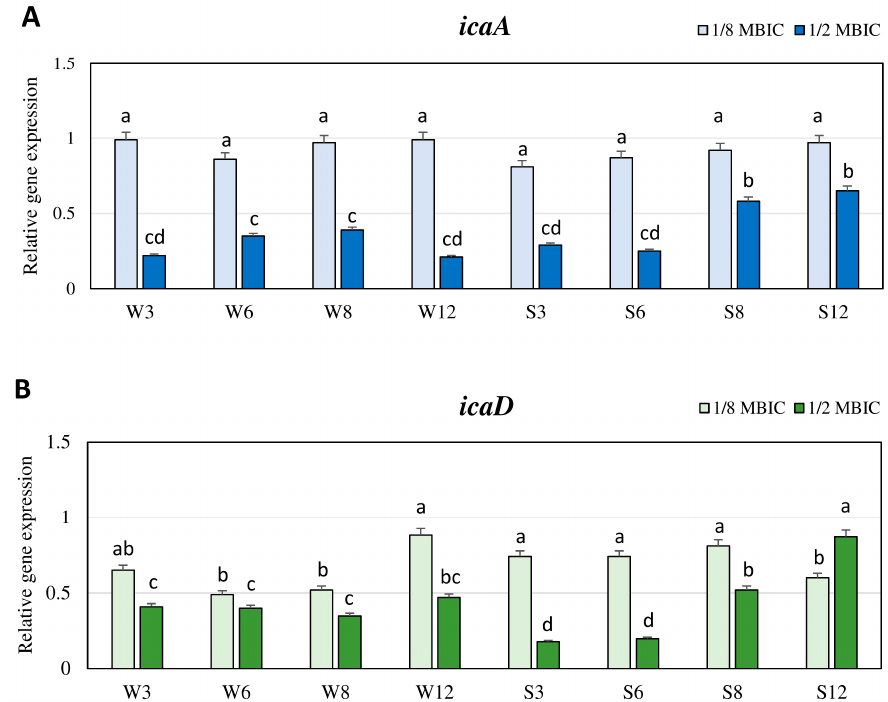
Figure 3. Transcriptional reprogramming of icaA ( A ) and icaD ( B ) genes in MRSA strains treated with TC under biofilm growth condition. Gene expression data were normalized to the rpoB reference gene. Results are shown as n -fold changes (mean ± SD) in the target gene expression compared to the control (biofilm untreated with TC). Significant di ff erences in relative gene expression among examined MRSA samples were marked by di ff erent letters (a, b, c, d) (Tukey’s test; p < 0.05). W: weak producer of biofilm; S: strong producer of biofilm; 3, 6, 8, 12: time of bacterial growth (h); MBIC: minimum biofilm inhibition concentration. Each assay was performed three times and the results were